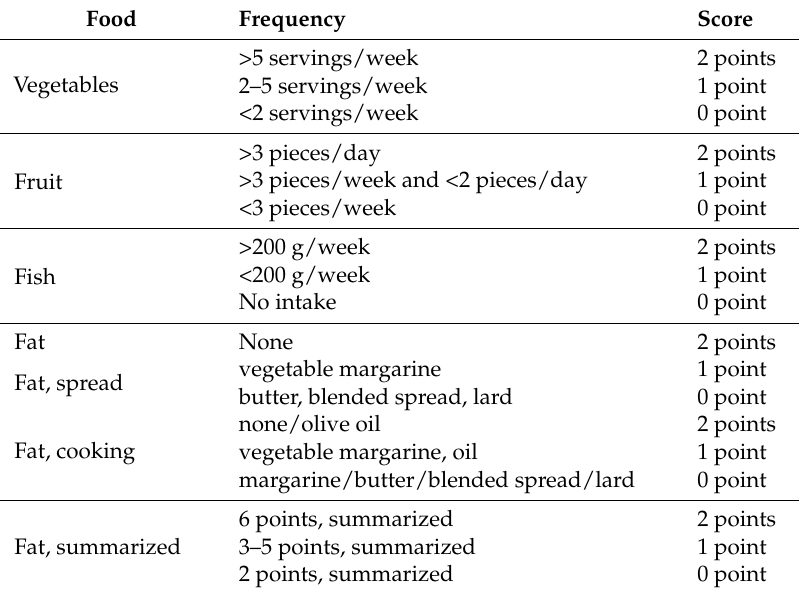
Table 1. Characteristic of Dietary Quality Score (DQS).